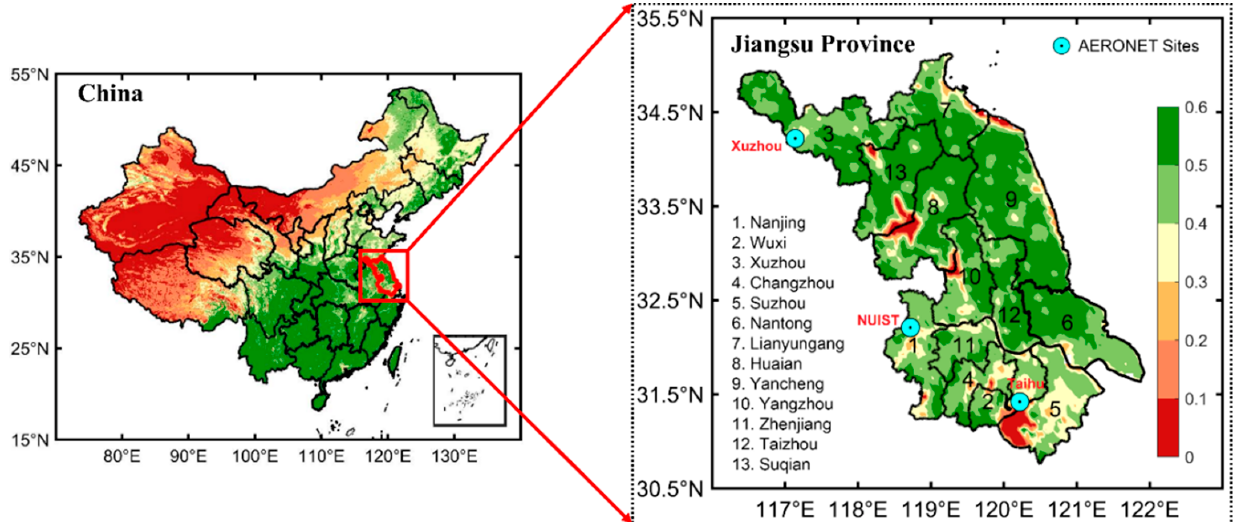
Figure 1. Map of Jiangsu Province with major cities, China. The background image reveals the multiyear (2000–2020) averages of MODIS NDVI, with arid surfaces (NDVI < 0.2), lighter or sparse vegetation (0.2 < NDVI < 0.4), moderate vegetation (0.4 < NDVI < 0.5), and dark vegetation (NDVI > 0.5).